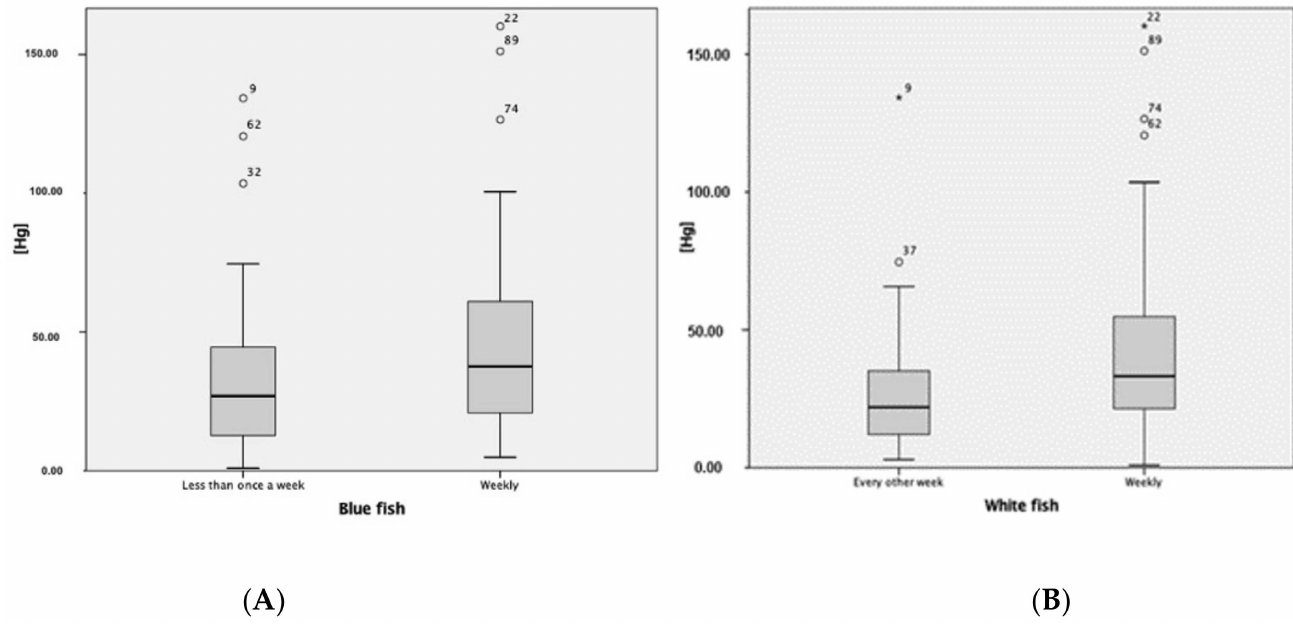
Figure 1. Correlation between Hg concentrations and consumption of blue fish (Spearman’s Rho: 0.23, p < 0.018) and white fish (Spearman’s Rho: 0.35, p < 0.001). ( A ) The concentrations of Hg detected are significantly higher in those cases in which the consumption of oily fish is weekly. ( B ) The concentrations of Hg detected are significantly higher in those cases in which the consumption of white fish is